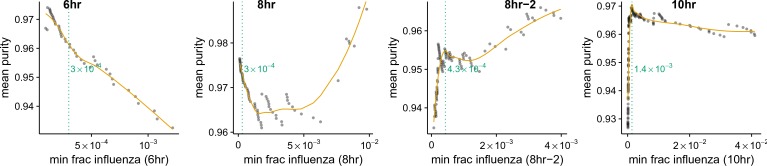
Thresholds for calling infected cells.Cell lysis can lead cells to the spurious association of small amounts of extraneous mRNA with individual cells. We wanted to avoid classifying as infected cells that had simply acquired such lysis-derived viral mRNA. The amount of lysis-derived viral mRNA will vary among samples as a function of both the lysis rate during the cell preparation (which always varies slightly from sample to sample in the 10X procedure) and with the amount of total viral mRNA for that sample (the more viral mRNA, the more there is to be acquired from lysed cells). As is shown in Figure 4B, the 8 hr-2 and 10 hr sample clearly have an enrichment of mixed barcodes in cells with small numbers of viral mRNA. For each sample, we calculated the mean purity of all cells with at least the indicated amount of viral mRNA, and determined the threshold amount of viral mRNA where purity no longer increased by finding the first maxima in a loess curve fit (orange line). We called the threshold at this point of maximum purity (dotted green line). For the 6 hr and 8 hr samples there is no indication of contamination from lysis-derived reads, as Figure 4B shows no increase in mixed barcodes in low viral mRNA cells. Therefore, for these samples we simply set a threshold of requiring at least 2×10-4 of the total mRNA to come from virus, which corresponds to ∼2 viral mRNAs for the typical cell with 104 total reads (Figure 3B).